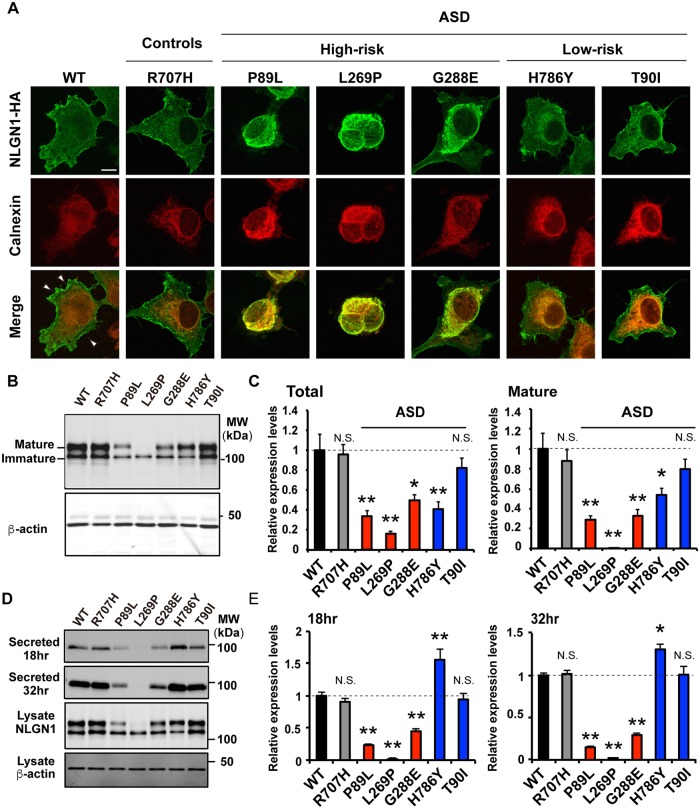
Pathogenic NLGN1 variants exhibit abnormal sub-localization and expression.(A) Fluorescence images of COS7 cells transfected WT or mutant NLGN1 with HA-tag. Endoplasmic reticulum (ER) was stained with calnexin. Three pathogenic variants (P89L, L269P, and G288E) were trapped in ER, and failed to traffic the plasma membrane. Scale bar indicates 10 μm. (B) Representative images of western blots of cell lysates from COS7 cells transfected with HA-tagged NLGN1. NLGN1 was detected by anti-HA tag. The expected molecular weight for the NLGN1: glycosylated mature NLGN1 (~110 kDa), non-glycosylated immature NLGN1 (~100 kDa). (C) Quantitative analysis of the western blots for total (left) and glycosylated (right) NLGN1. The expression of NLGN1 variants is normalized to the corresponding β-actin. NLGN1 variants observed in ASD subjects showed decreased expression level compared to WT. Data represents mean ± S.E.M. of four samples from three independent experiments (one-way ANOVA followed by Tukey-Kramer’s multiple comparisons test, *p<0.05, **p<0.01 compared with WT). Gray, red, and blue bars indicate the non-pathogenic variant, “high-risk”, and “low-risk” pathogenic variants, respectively. (D) Representative image of western blots of conditioned media (collected at 18 and 32 hr after transfection), cell lysates (collected at 32 hr after transfection), and β-actin as an internal control. Both cleaved NLGN1 in media and full-length NLGN1 in cell lysate were detected by anti-HA tag. (E) Quantification of cleaved NLGN1 with the HA-tag inserted in extracellular domain in conditioned media. Relative expression levels at 18 hr post-transfection (left) and 32 hr post-transfection (right) are shown. Cleaved NLGN1 was decreased in three pathogenic variants (P89L, L269P, and G288E) and increased in H786Y variant compared to WT. Data represents mean ± S.E.M. of six samples (one-way ANOVA followed by Tukey-Kramer’s multiple comparisons test, *p<0.05, **p<0.01 compared with WT).